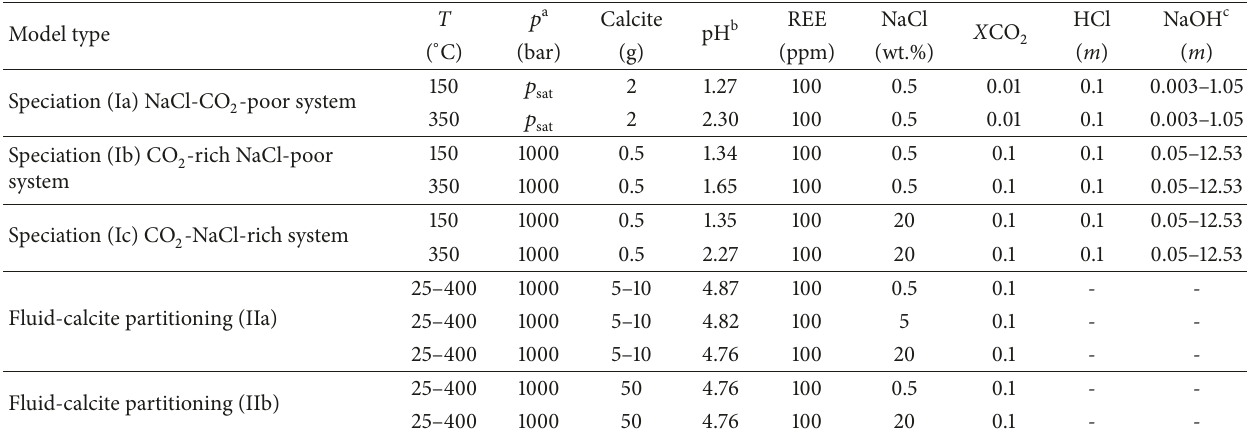
Table 3: Starting conditions for the different model types. Parameters that were varied include temperature, pressure, salinity and X CO 2 ; REE concentrations were fixed at 100ppm.